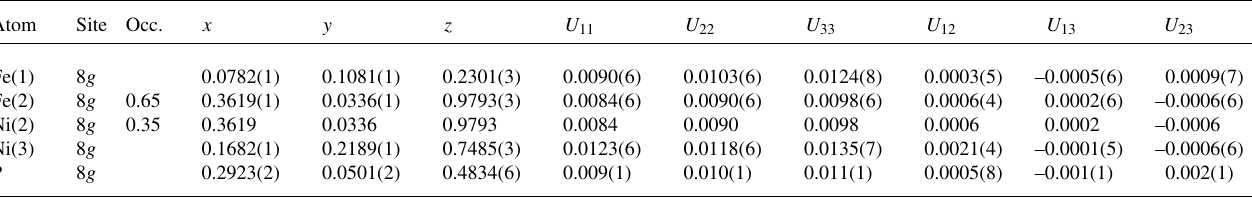
Table 2. Atomic coordinates and displacement parameters (in Å 2 ) . Atom Site